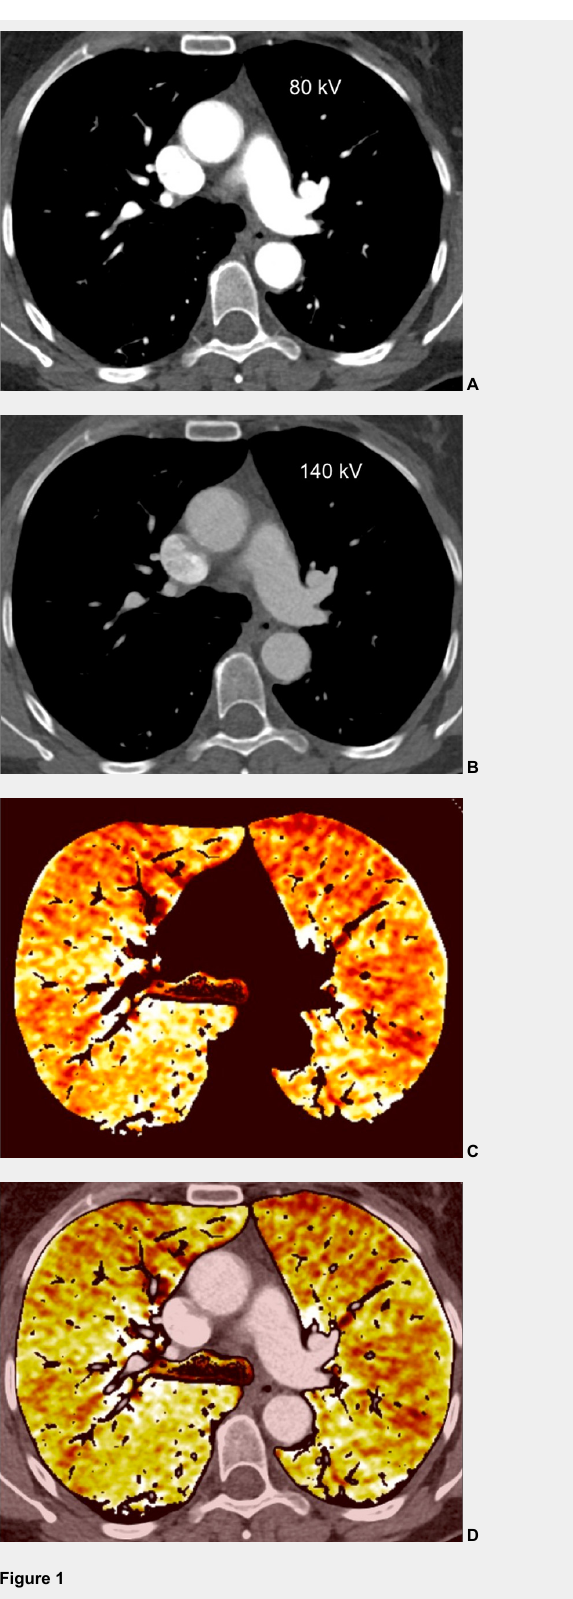
Technical principles. The dual-energy system with two X-ray tubes permits simultaneous 80 ( A ) and 140 kV ( B ) image acquisition in order to generate an iodine map ( C ) fused with mediastinal reconstructions ( D